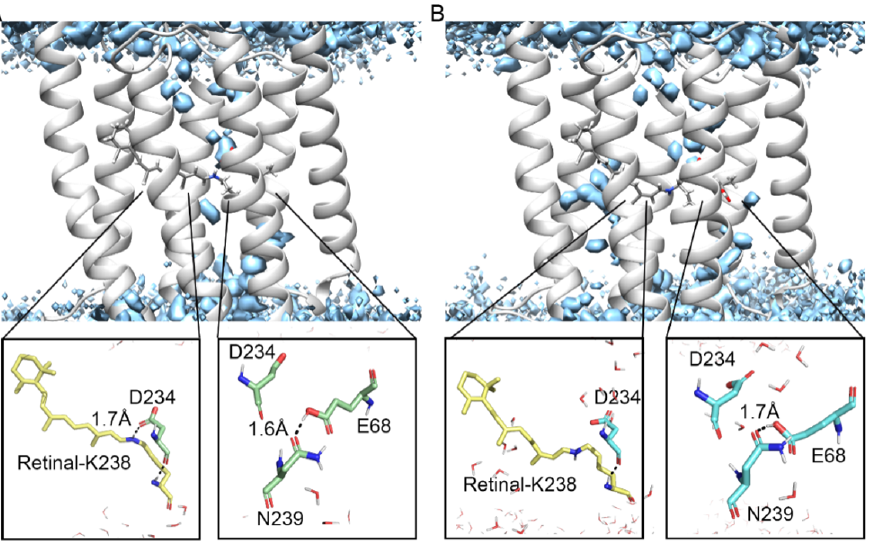
Figure 3. Water distributions in ( A ) GtACR1- trans and ( B ) GtACR1- cis . The last 50 ns equilibrium trajectories were picked for grid water density